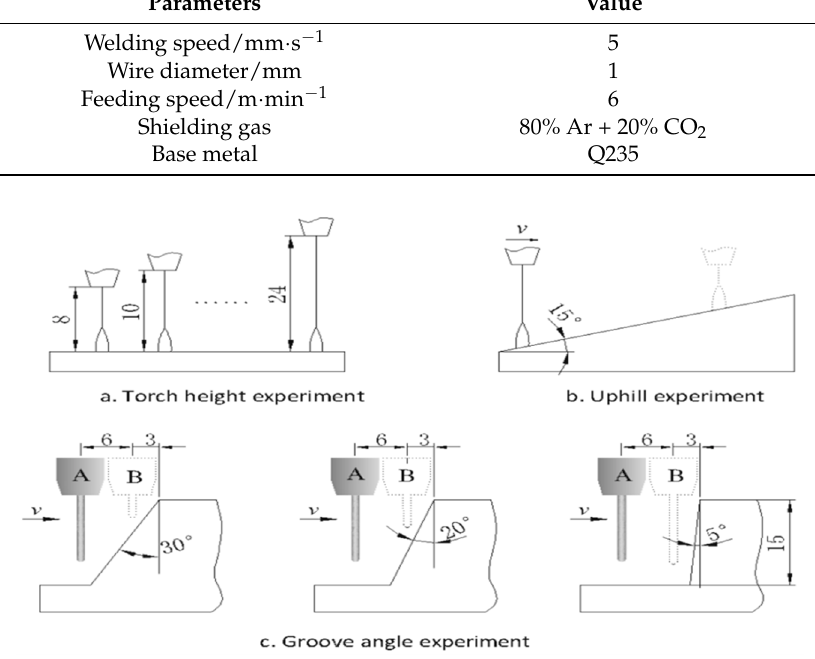
Figure 12. Experimental schemes.